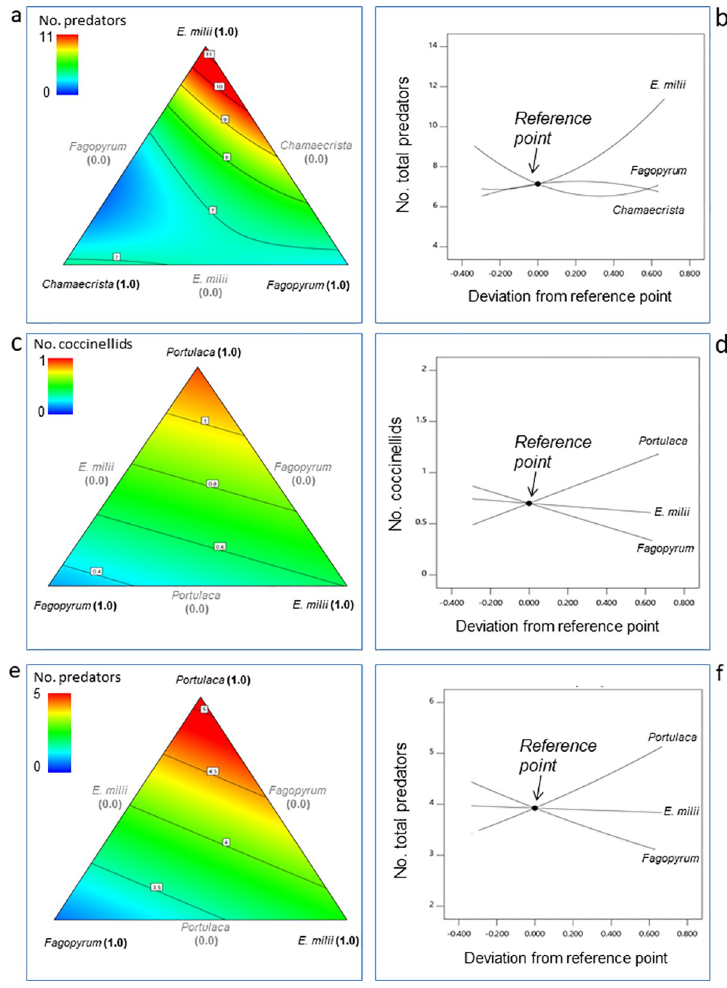
Fig 5. Response surface plots of the occurrence of insect predators in the Summer 2017 and Summer 2018 experiments. The 3-component mixture was composed of Euphorbia milii (crown-of-thorns), Chamaecrista fasciculata (partridge pea), and Fagopyrum esculentum (flowering buckwheat) in the Summer 2017 Experiment and Euphorbia milii (crown-of-thorns), Portulaca umbraticola (ornamental portulaca), and Fagopyrum esculentum (flowering buckwheat) in the Summer 2018 Experiment. a ) Contour plot of the number of all predators combined in the Summer 2017 Experiment. b ) Trace plot of the effects of the E . milii , F . esculentum , and C . fasciculata on the number of all predators combined. c ) Contour plot of the number of coccinellids in the Summer 2018 Experiment. d ) Trace plot of the effects of the E . milii , F . esculentum , and P . umbraticola on the number of coccinellids. e ) Contour plot of the number of all predators combined. f ) Trace plot of the effects of the E . milii , F . esculentum , and P . umbraticola on the number of all predators